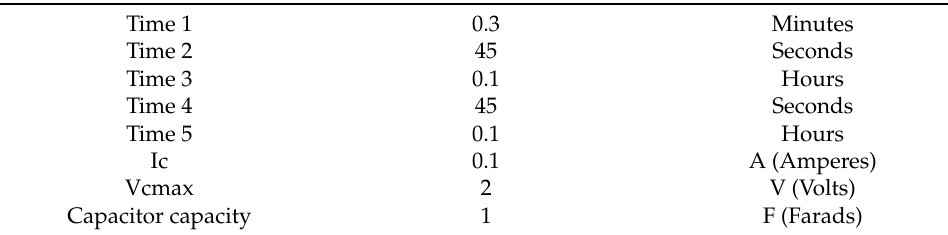
Table 4. Data programmed for the second loading and unloading